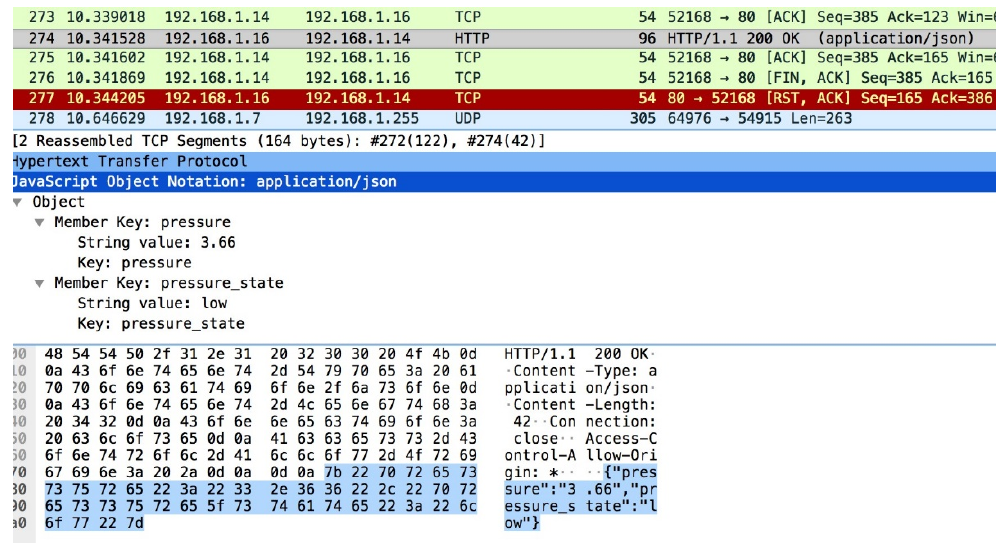
Figure 11. The capture of values under the normal scenario.